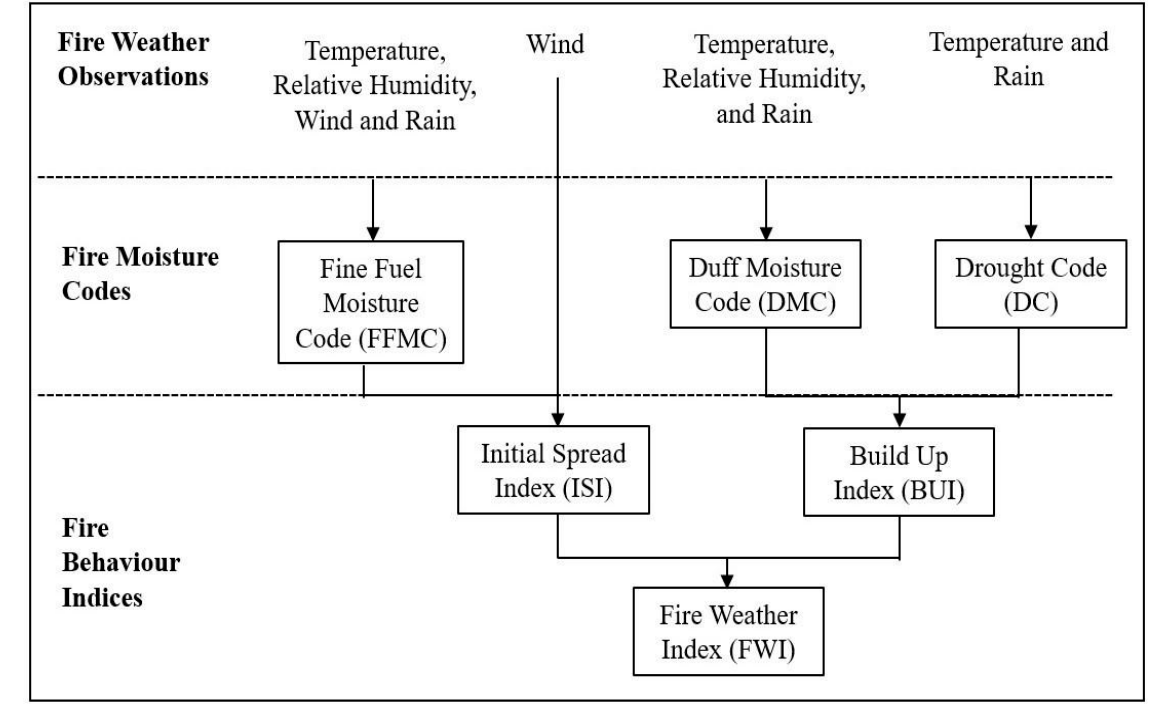
Figure 1. Structure of the Canadian Forest Fire Weather Index (adapted from [4]).